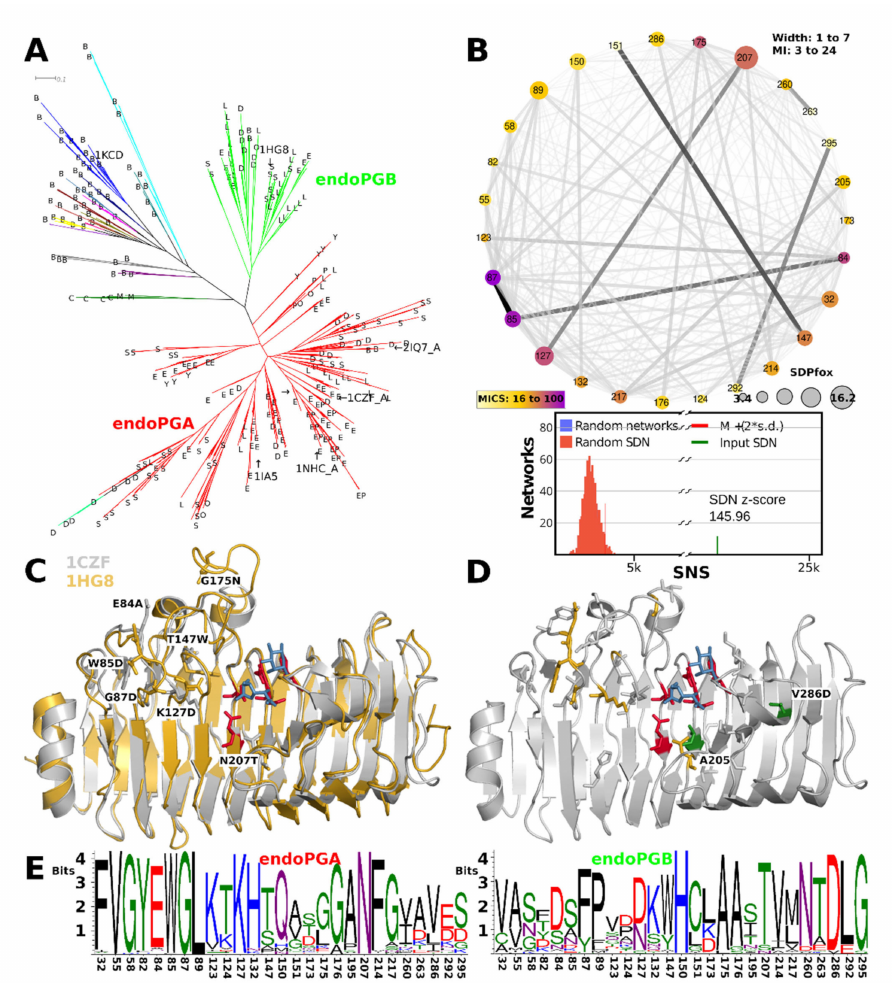
Figure 8. Functional diversification of the ascomycete endoPGA and endoPGB subfamilies involves T3 loops that cover N-terminal subsites. ( A ) Fungal endoPG tree clustered with HMMERCTTER. The taxonomic distribution is indicated by letters: B: basidiomycete; C: chytridiomycete; D: